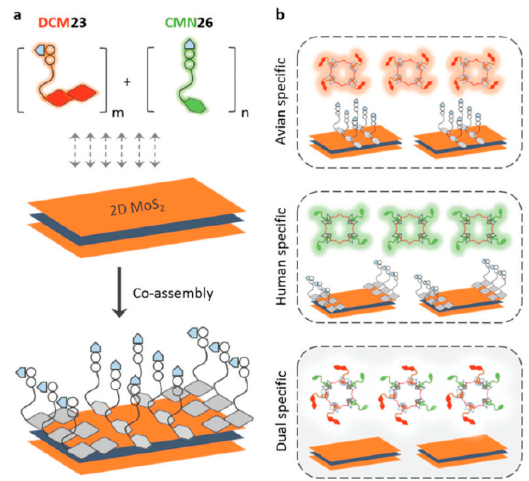
Figure 14. Schematic illustration of ( a ) the co-assembly of sialyl–glycan–fluorophore conjugates with different emission colors to 2D MoS 2 , producing the 2D glycosheet and ( b ) the use of the 2D glycosheet for identification of the single or dual receptor specificity in influenza viruses. Reproduced with permission from [127]. Copyright the Royal Society of Chemistry, 2017.